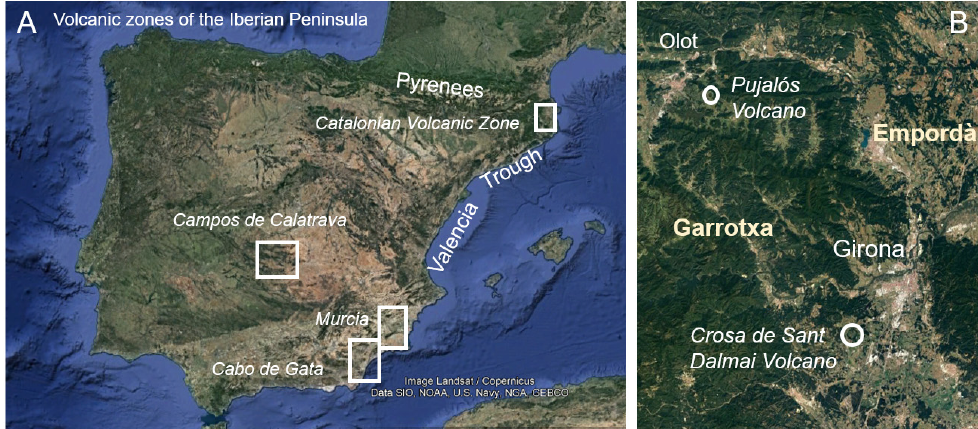
Figure 6. ( A ) Volcanic zones of the Iberian Peninsula, excluding the islands Columbretes and Al- borán. ( B ) Detail of the Catalonian Volcanic Zone indicating the three regions: L’Émpordà and La ( B ) Detail of the Catalonian Volcanic Zone indicating the three regions: L’ É mpord à and La Garrotxa, Garrotxa, as well as the location of the Pujalós and La Crosa de Sant Dalmai volcanoes. These images as well as the location of the Pujal ó s and La Crosa de Sant Dalmai volcanoes. These images are from are from Google Earth Pro. Google Earth